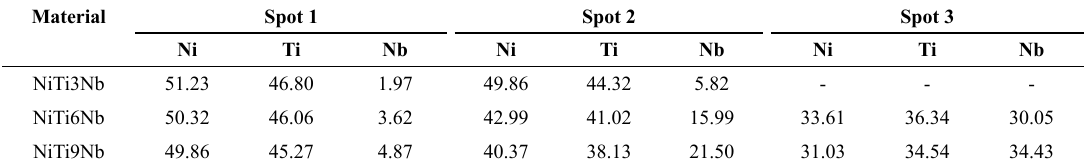
Table 2. EDS results (% atomic).